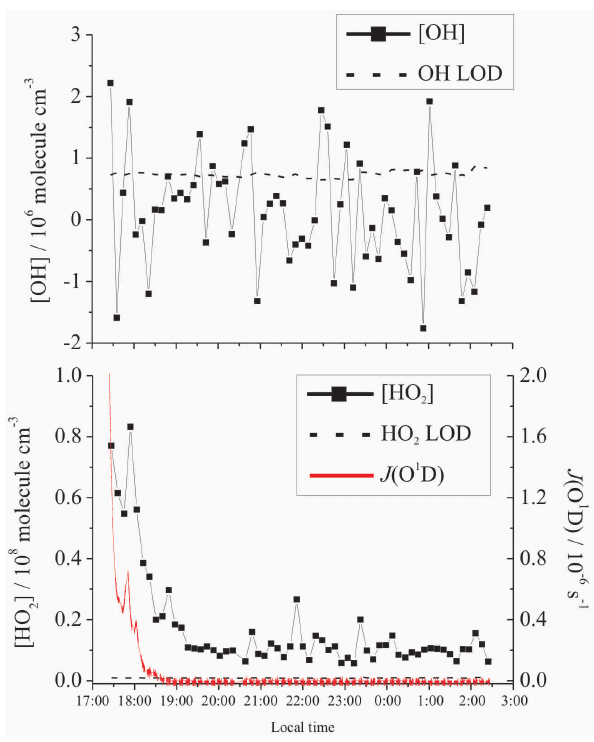
Fig. 10. The time-series of the five-minute averaged [OH] and four- minute averaged [HO 2 ] (solid black lines) and one-second J (O 1 D) (red line) for the night of 7 September 2009; the dashed black lines represents the five-minute and four-minute LODs ( S / N = 1) for OH and HO 2 ,